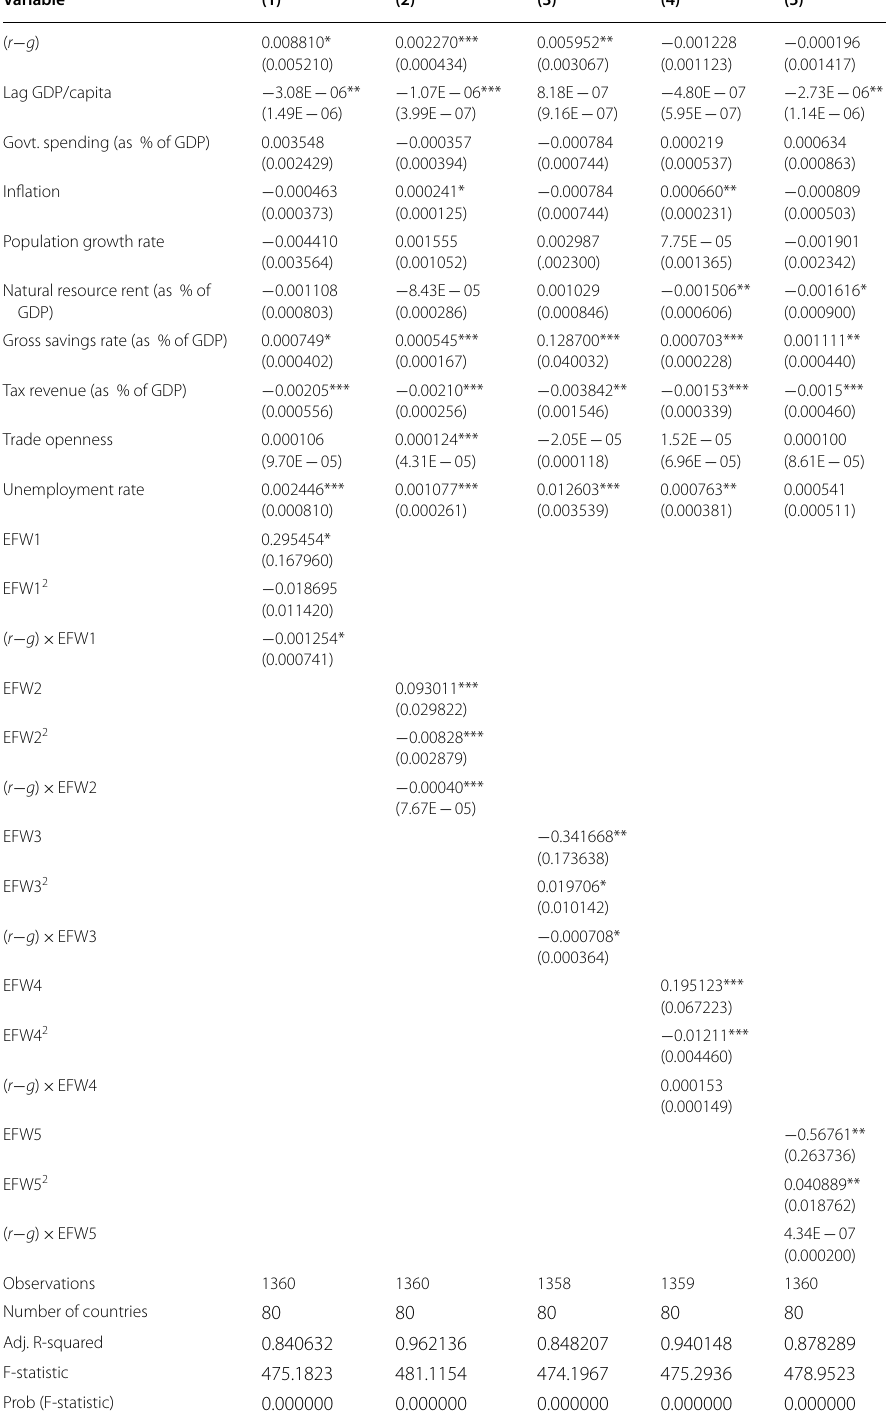
Table 8 2SLS estimation results of five areas of economic